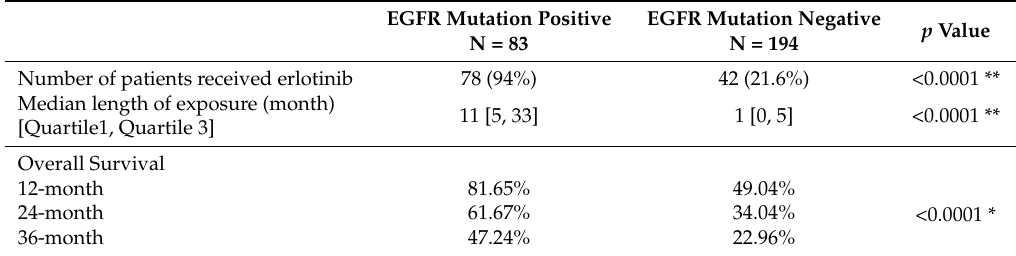
Figure 1. Kaplan–Meier curve of overall survival of patients with negative (Orange, EGFR-) and positive (Blue, EGFR+) EGFR mutations. The numbers in orange and blue represent the number of patients at risk respectively. The numbers in green represent the numbers of months from the diagnosis of stage IV NSCLC to death. NSCLC, non-small cell lung cancer. Table 6. Length of treatment with erlotinib and overall survival for patients with positive or negative EGFR mutation